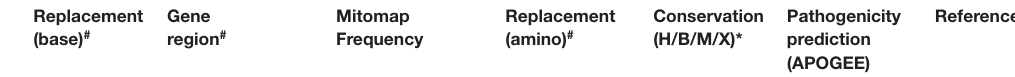
TABLE 2 | The mtDNA variants in the severe patient